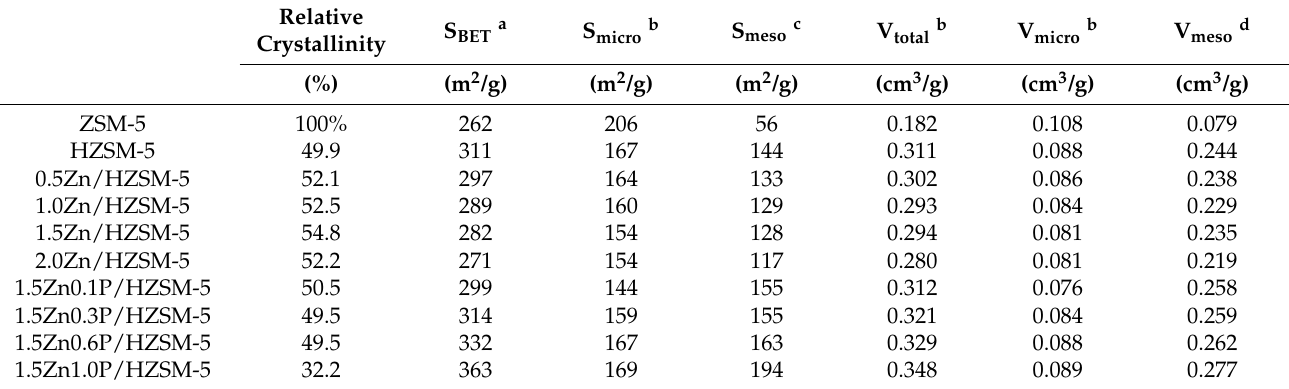
Figure 2. N 2 absorption-desorption isotherms and pore size distribution (insert image) of ZSM-5, HZSM-5, Zn modified ( a ) and Zn-P co-modified ( b ) samples. Table 1. Textural properties of ZSM-5, HZSM-5, Zn modified and Zn-P co-modified samples.